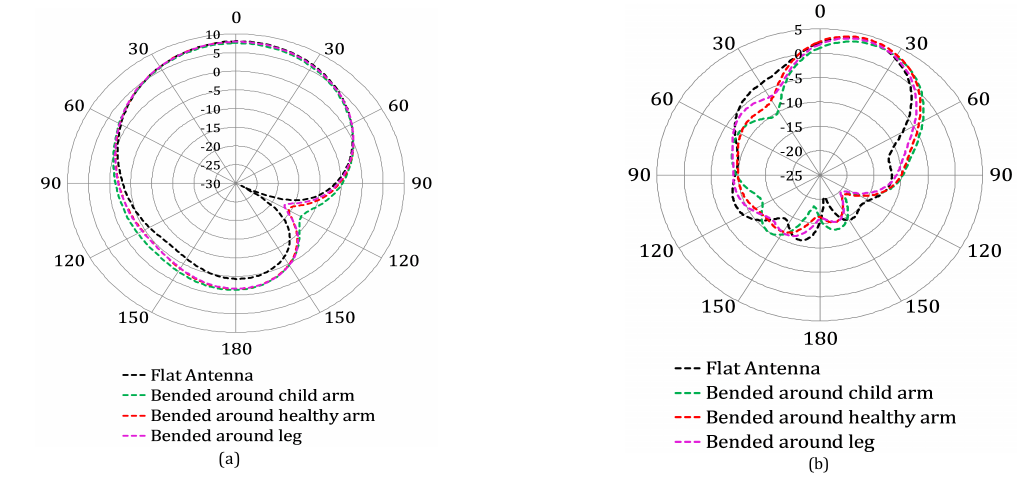
Figure 19. Off-body gain patterns of the conventional dual band antenna at ( a ) 2.5 GHz and ( b ) 5.2 GHz.